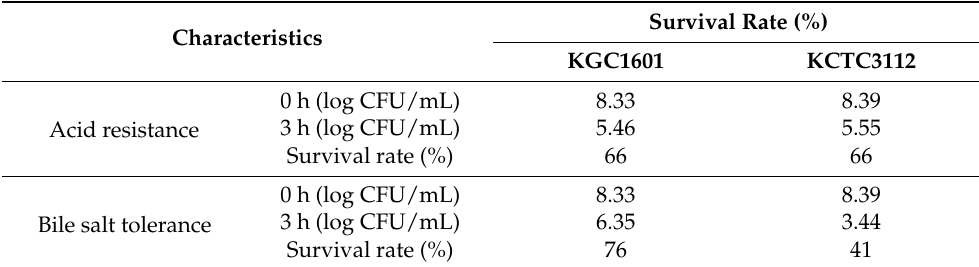
Table 5. Acid resistance and bile salt tolerance of L. fermentum KGC1601 and KCTC3112.